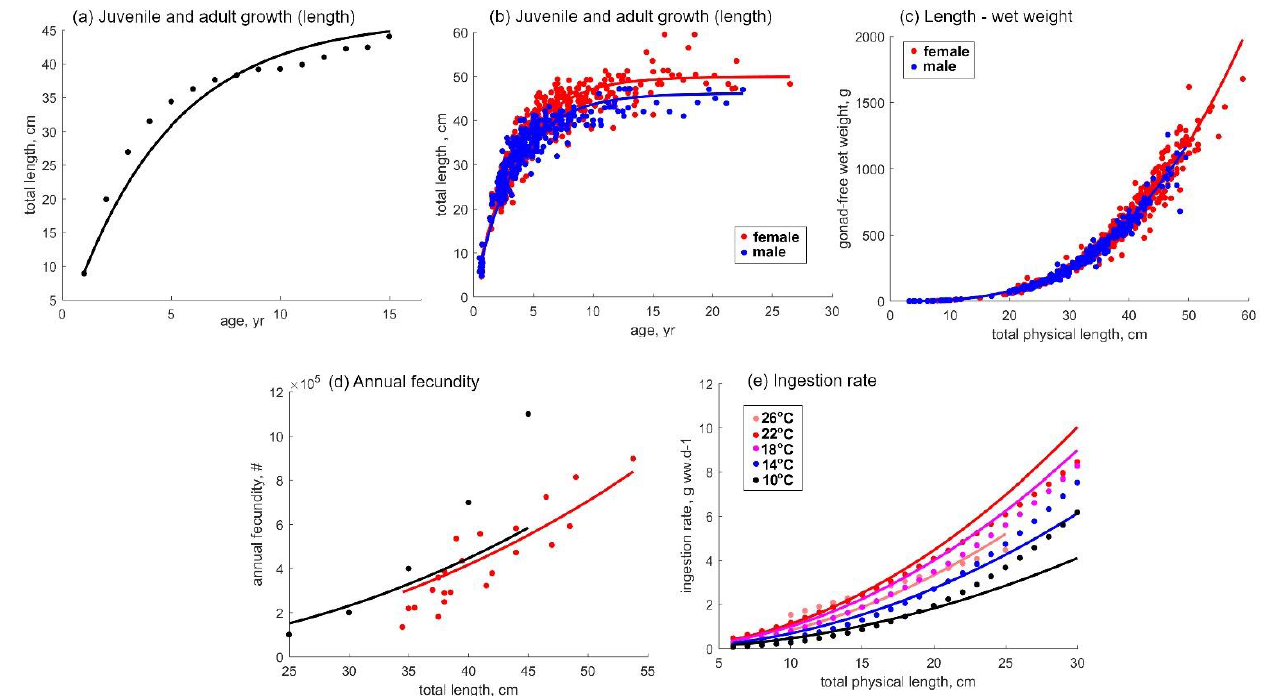
function of incubation or rearing temperature; ( d – f ): larval growth in total length and dry weight over time. Data sources and corresponding conditions (estimated scaled functional response f , simulated temperature T): Panels a-d: [41]( f = 0.4451, T = 10, 13, 16, 19 °C for panels ( a , b ), T = 13, 16, 18, and 22 °C for panel ( c ), and T = 10, 13, 16, 19, 22 °C for panel ( d )); Panel ( e ): [100] ( f = 0.305, T = 11.2 °C for incubation (fertilization to hatching), 16.1 °C from hatching to birth, and 19.1 °C from birth on- ward; Panel ( f ): [40] — mean values ( f = 0.4813, T = 12 °C for incubation (fertilization to hatching), then T = 15 °C).